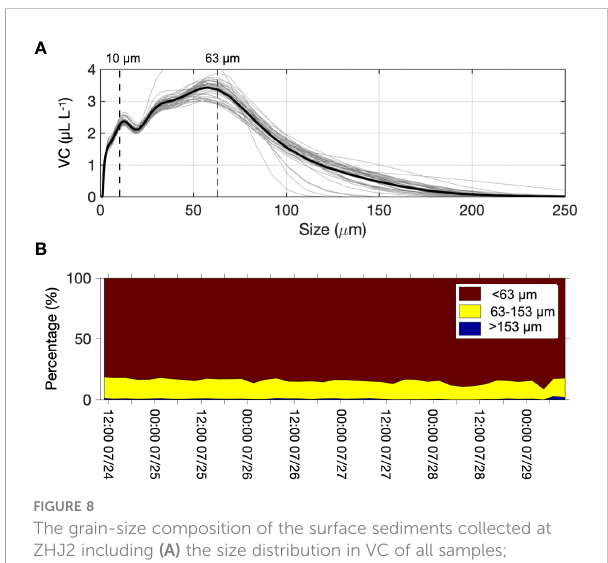
FIGURE 8 The grain-size composition of the surface sediments collected at